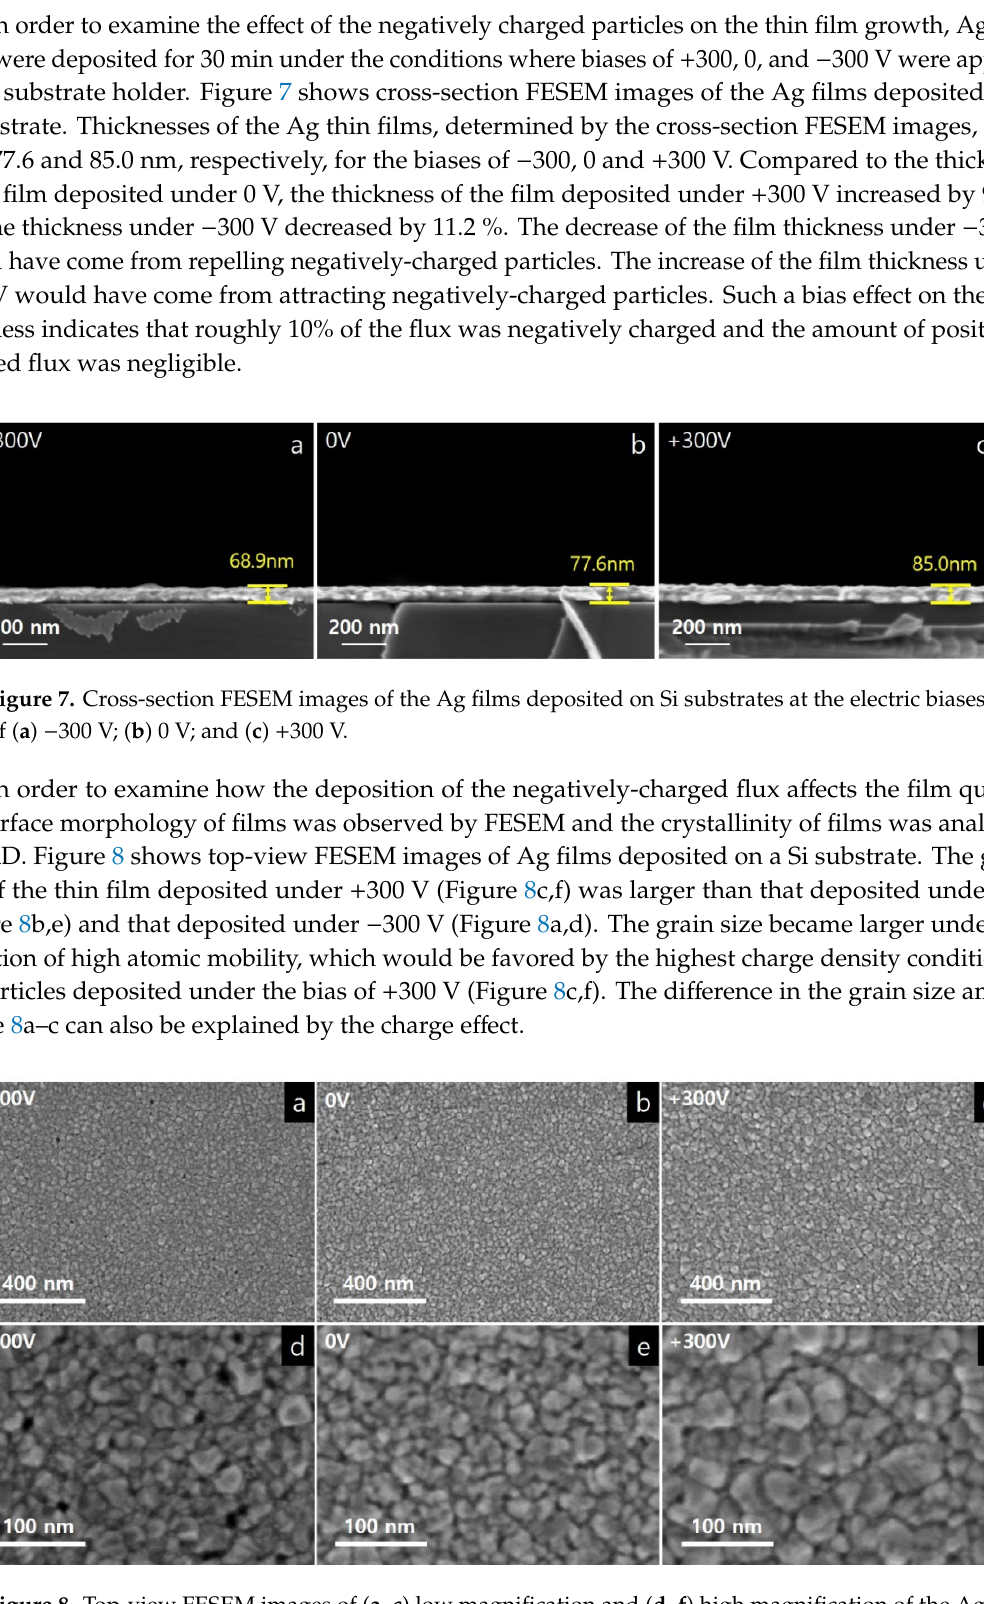
Figure 8. Top-view FESEM images of ( a – c ) low magnification and ( d – f ) high magnification of the Ag films deposited on Si substrates at the electric biases of ( a , d ) −300 V ( b , e ) 0 V and ( c , f ) +300 V.